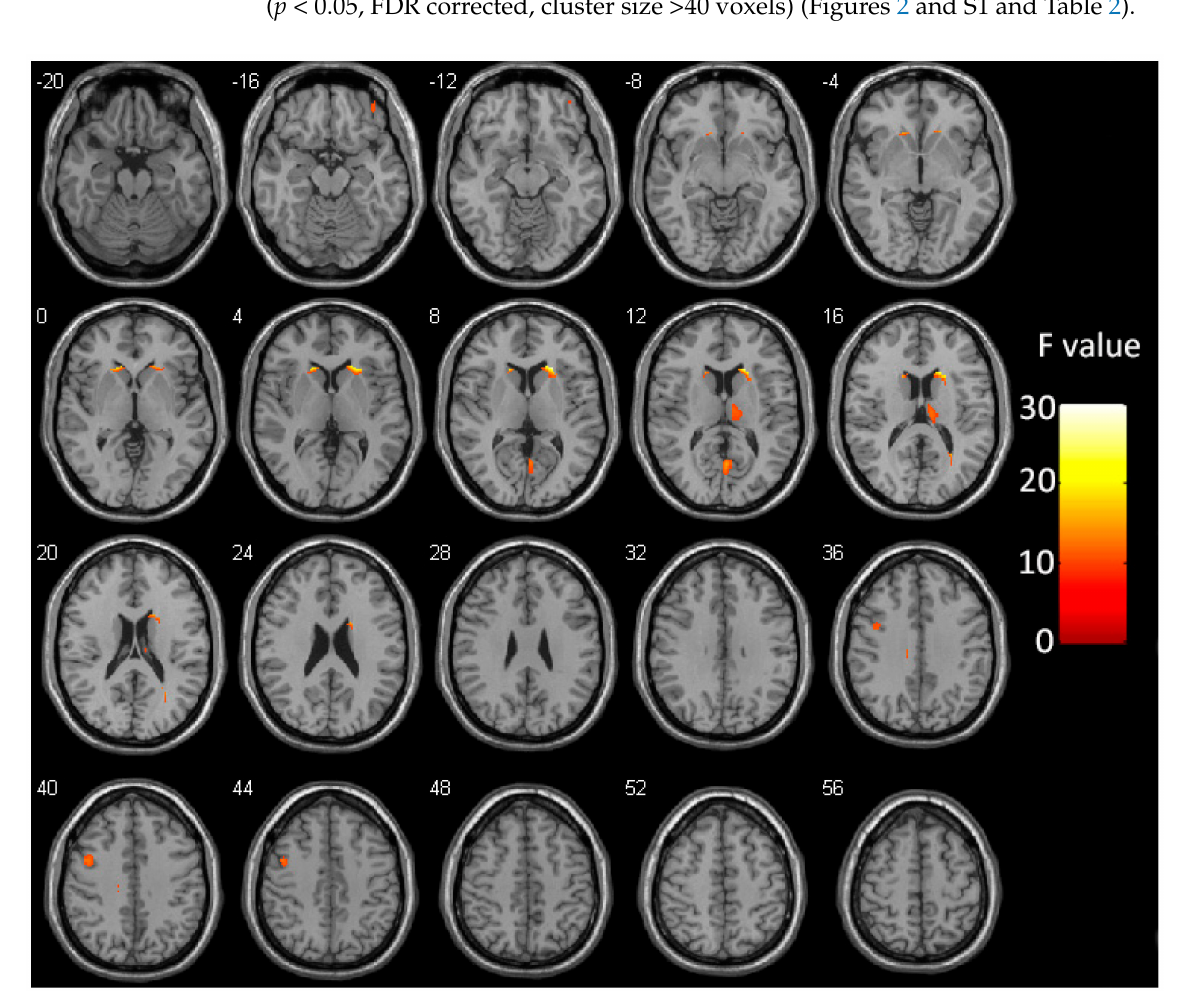
Figure 2. Whole brain group differences in GMV. Color regions represent significant differences in GMV ( p < 0.05, FDR corrected, cluster size >40 voxels). The color bar represents the corresponding F-values. GMV—gray matter volume; FDR—false-discovery